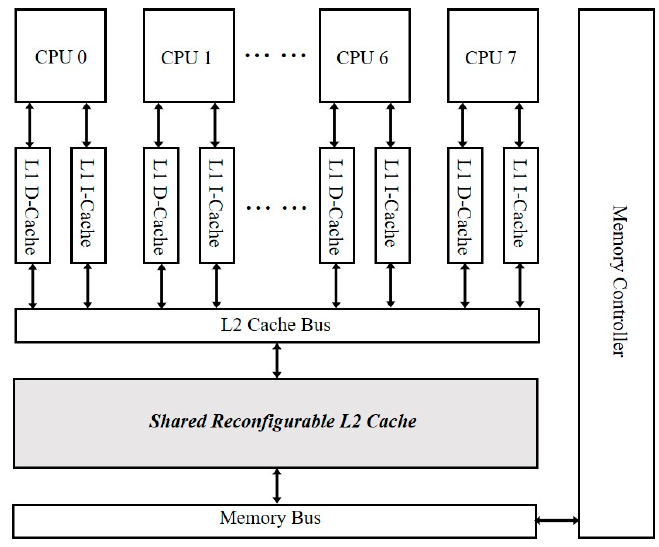
Figure 11. Multicore system with the proposed decision tree-based adaptive reconfigurable cache.